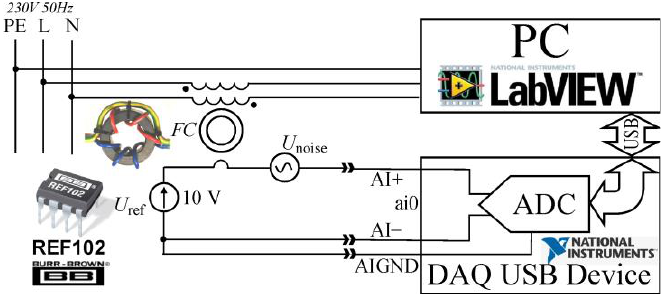
Figure 2. Schematic diagram of the measurement system. Table 2. Parameters of the REF102 BURR-BROWN reference voltage source.